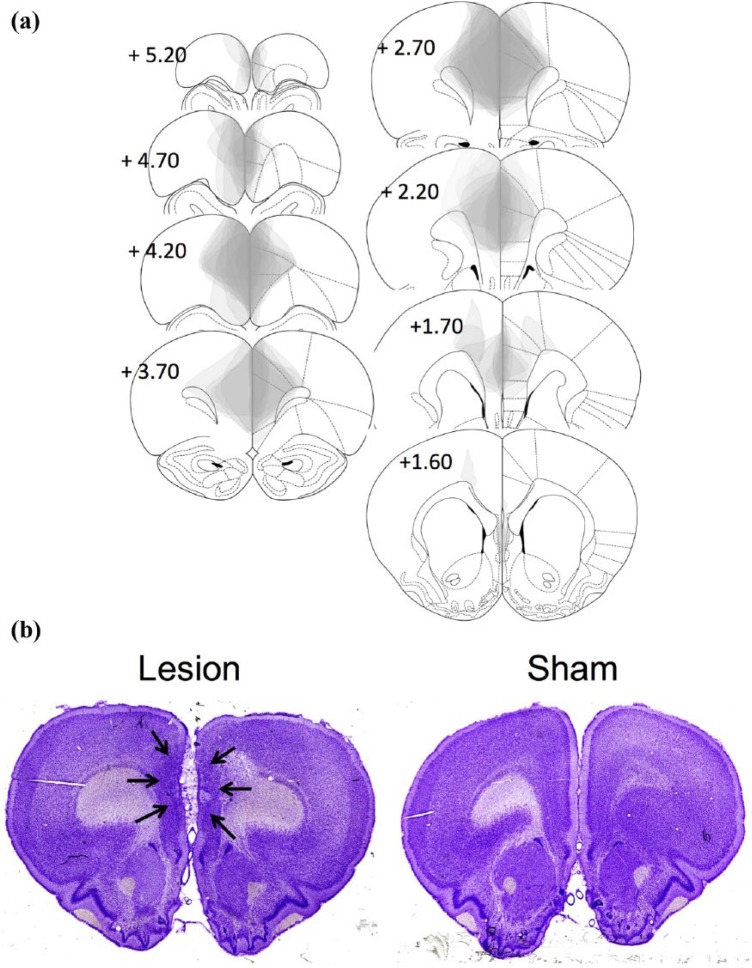
Histological analysis of mPFC lesions: (a) schematic diagrams of mPFC
lesions. Grey scale shading indicates extent of neuronal loss across
subjects, with each subject represented as a separate stacked layer.
Diagrams are modified from Paxinos and Watson (28) and (b)
photomicrographs of cresyl-stained coronal sections, depicting
typical lesions of mPFC-lesioned (left) and sham-lesioned (right)
rats. Arrows indicate the site of lesion.